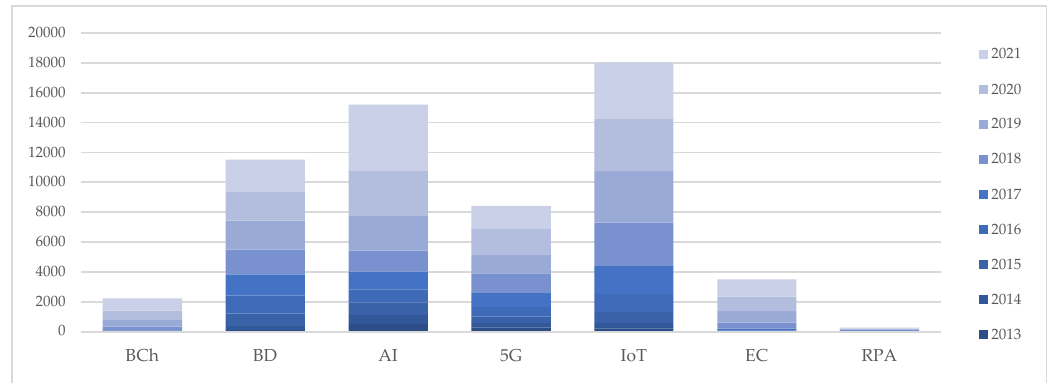
Figure 3. The publication analysis on emerging technologies from 2013 to 2021.